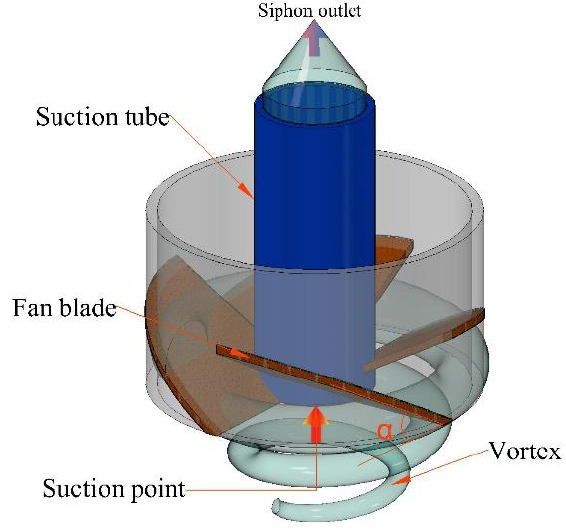
Figure 3. The model details of the fan blades, angle, and flow direction. Table 1. Geometric characteristics of the experimental test